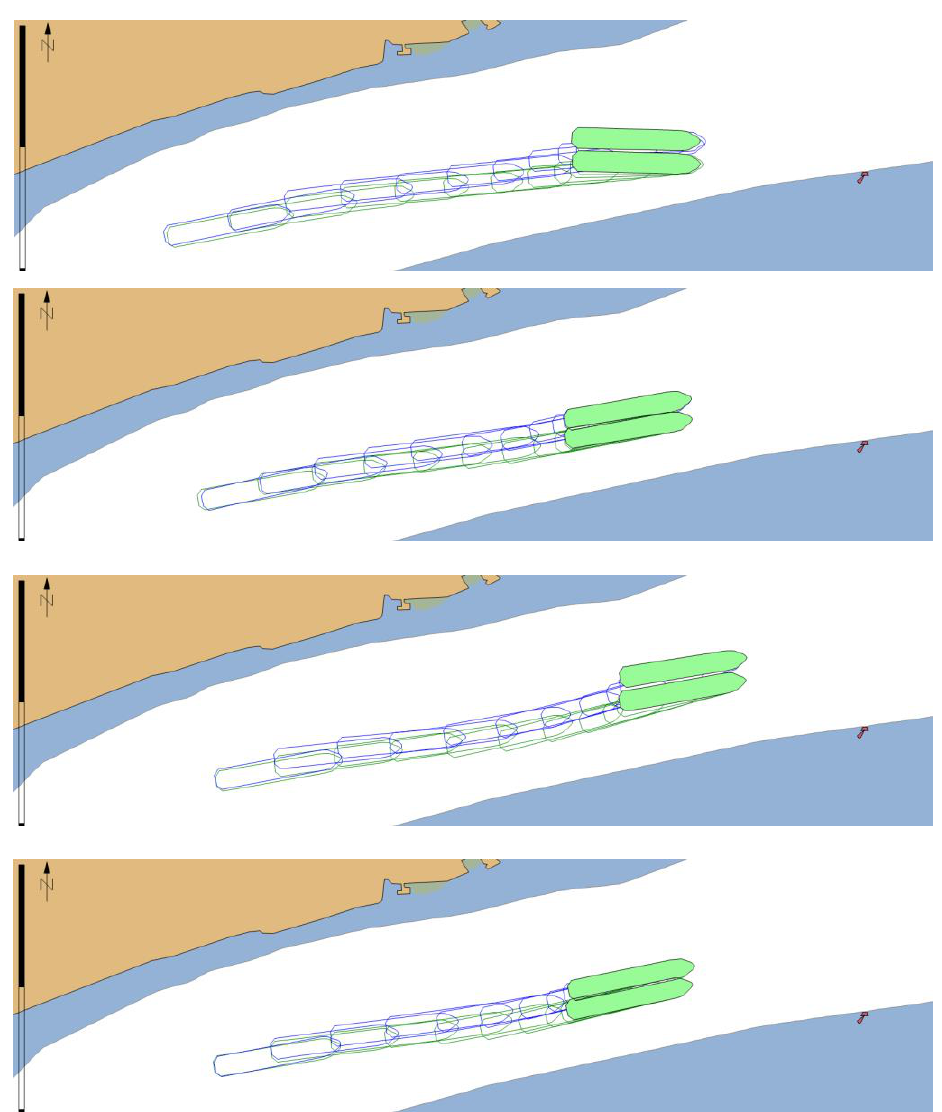
Figure 18. Example of 4 passages of the MASS with simulated GNSS signal deterioration – with integrity data presentation in ECDIS.